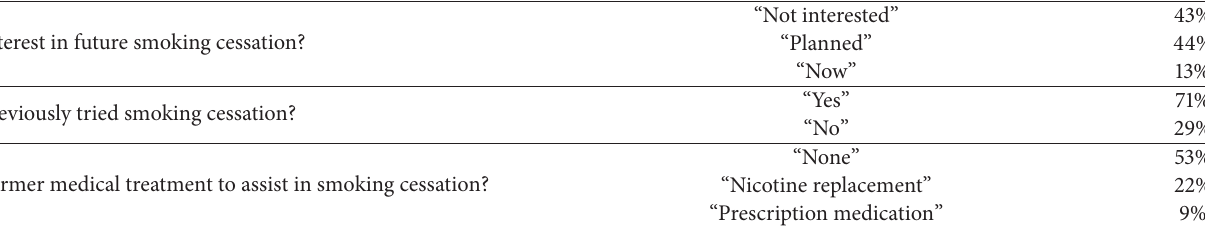
Table 3: Current smokers: smoking cessation ( 𝑁 = 670